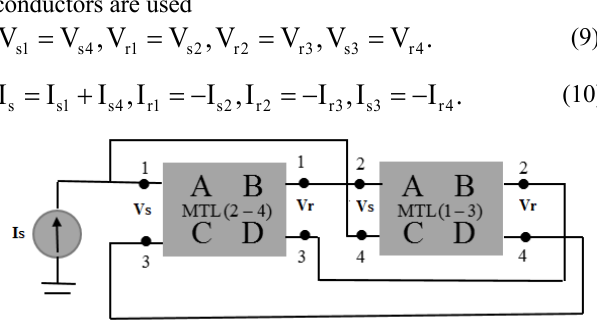
Figure 2: Representation of figure 1 as two-port